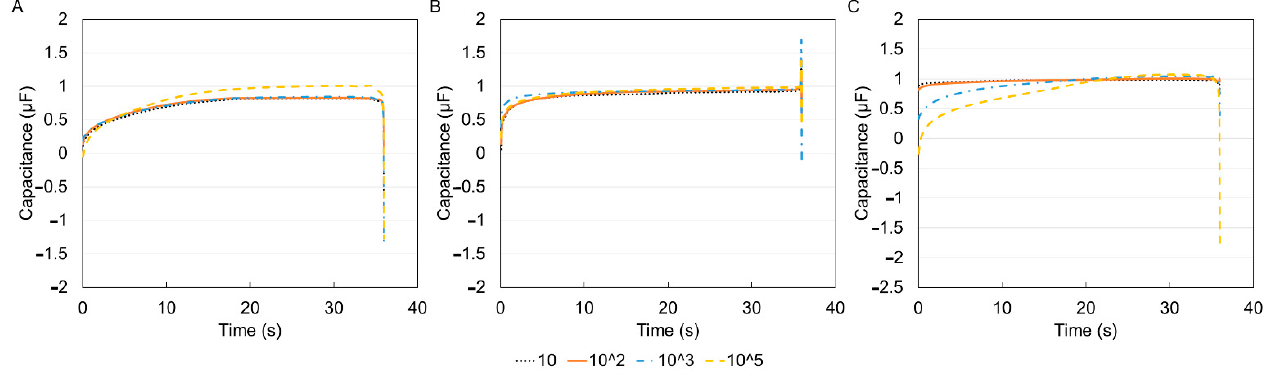
Figure 9. Capacitance–time curve for the three types of cells after media de-embedding ( A ) THP-1, ( B ) DCs, ( C ) MACs. De-embedding was performed by diving each of the concentration values in Figure 8 by their corresponding media value.